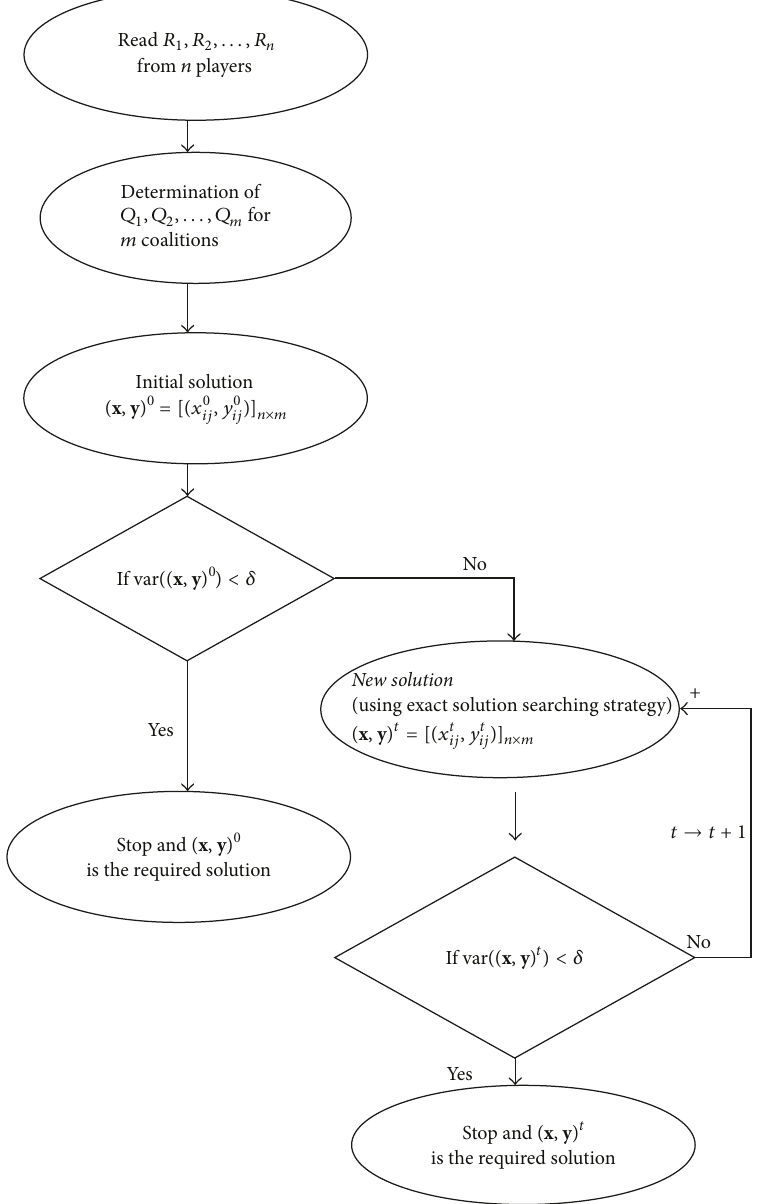
Figure 1: Flowchart of the allocation